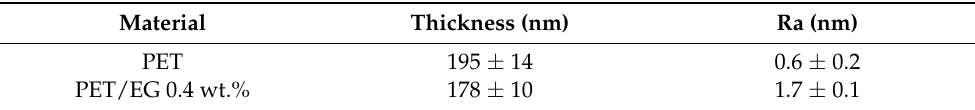
Table 1. Thickness and average roughness of PET and PET/EG 0.4 wt.% thin films as a result of three different